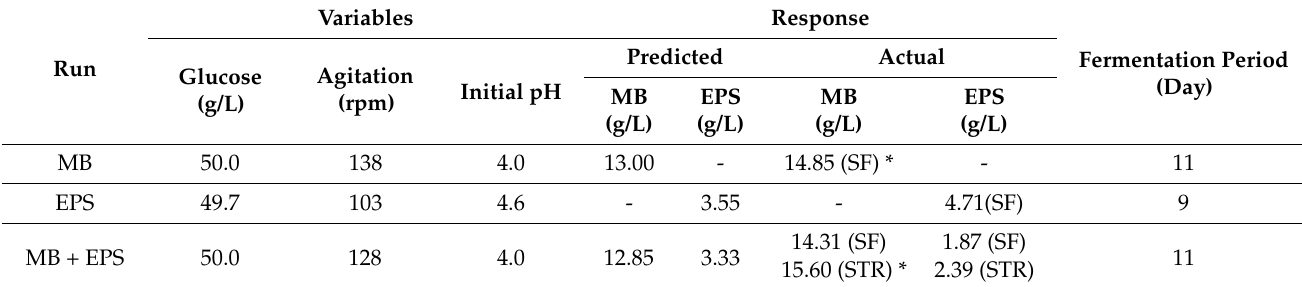
Table 5. Model validation of the optimized conditions in the shake flask and bioreactor.